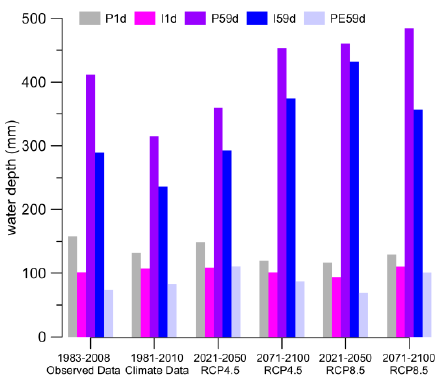
Figure 8. Average values associated to potential failure events every 30 years for the observed data and climate simulations, P 1d precipitation observed on the day of occurrence ( gray ), P 59d cumulative precipitation on the previous 59 days ( purple ), estimated infiltration rate (I 1d ) on the day of potential occurrence ( pink ) and the previous 59 days (I 59d ) ( blue ), and cumulative potential evaporation on the previous 59 days (PE 59d ) ( light blue ).